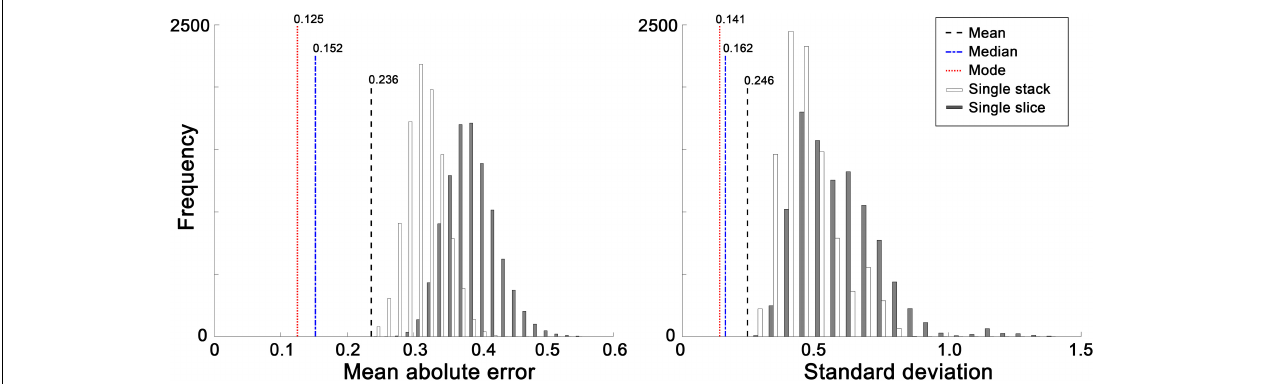
FIGURE 5 | Distributions of the averages and standard deviations of the absolute predicted age difference (PAD) using a single volume or a single slice. During 10,000 random selections, a single volume and a single slice were randomly selected in each subject. The mean absolute errors (MAEs) and standard deviations obtained using our method (mean, median, and mode) were significantly lower than those using a single volume or a single slice ( p < 0.001).